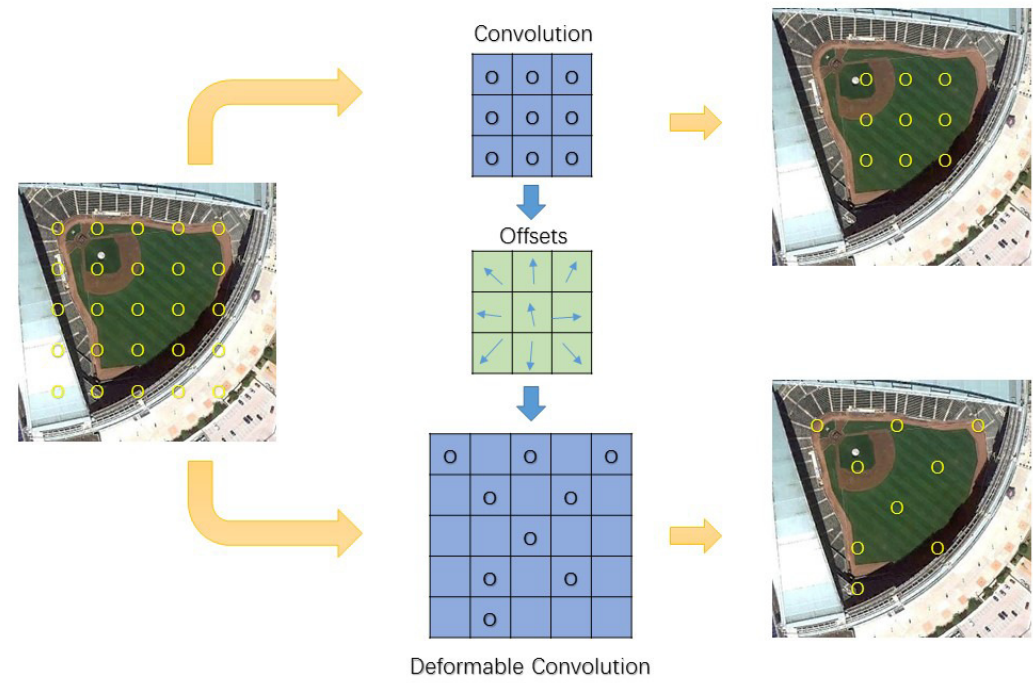
Figure 1. Illustration of deformable convolution on VHR (Very High Resolution) remote sensing